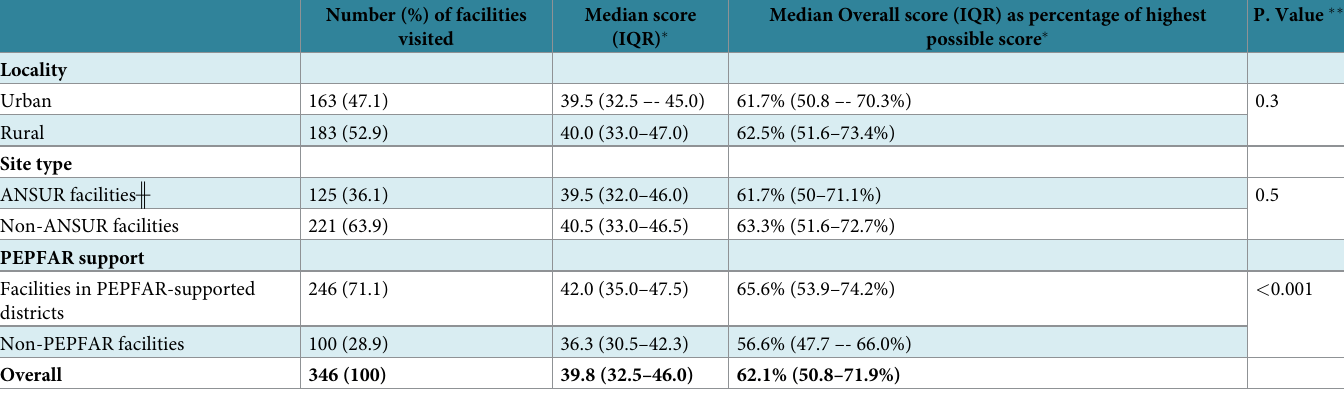
Table 3. Score by locality, site type and PEPFAR support: Quality of HIV rapid testing practices, South Africa. Number (%) of facilities